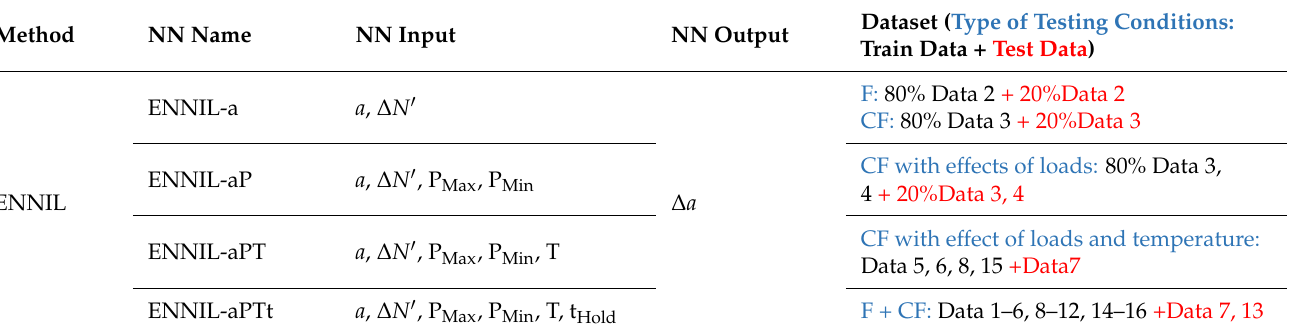
Table 6. List of modelling cases using ENNIL method.